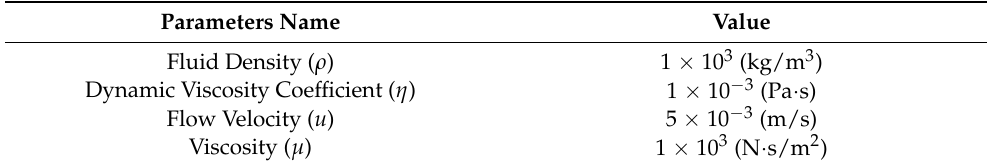
Table 1. The basic parameters of the simulation